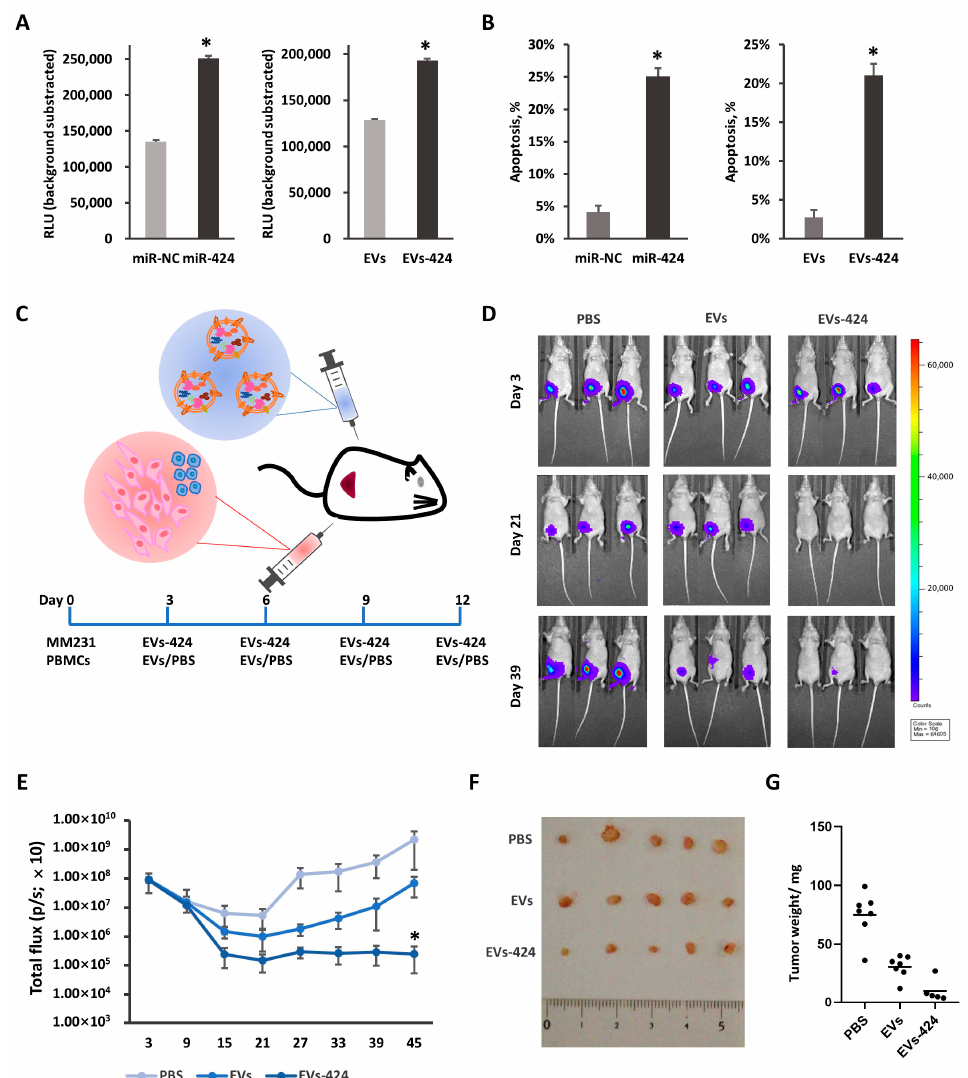
Figure 6. miR-424-5p delivered by EVs enhanced cytotoxicity against tumors. MM-231 cells were transfected with miR-424- 5p mimics or incubated with EVs-424, and cocultured with stimulated T cells for 16 h. Caspase 3/7 activities in the coculture system were assessed by a fluorometric assay ( A ). The apoptosis of tumor cells was measured by the LDH release assay ( B ). ( C ) Schematic diagram of animal model. MM231 (2 × 10 6 ) and stimulated PBMCs (1 × 10 6 ) were injected with Matrigel (100 µ L) into the fat pad of BALB/c nude mouse. After 72 h, 30 µ g of EVs-424 in 100 µ L of PBS was injected intratumorally. EVs were injected 4 times every 72 h. ( D ) Representative bioluminescence images of tumor-bearing mice measured at day 3 (upper), day 21 (middle) and day 39 (bottom). ( E ) Total bioluminescent signal (p/s) for each group at days 3, 9, 15, 21, 27, 33, 39 and 45. ( F ) Tumors dissected from mice of each group were weighed. ( G ) Representative images of the tumor-bearing mice and removed tumors. * p <